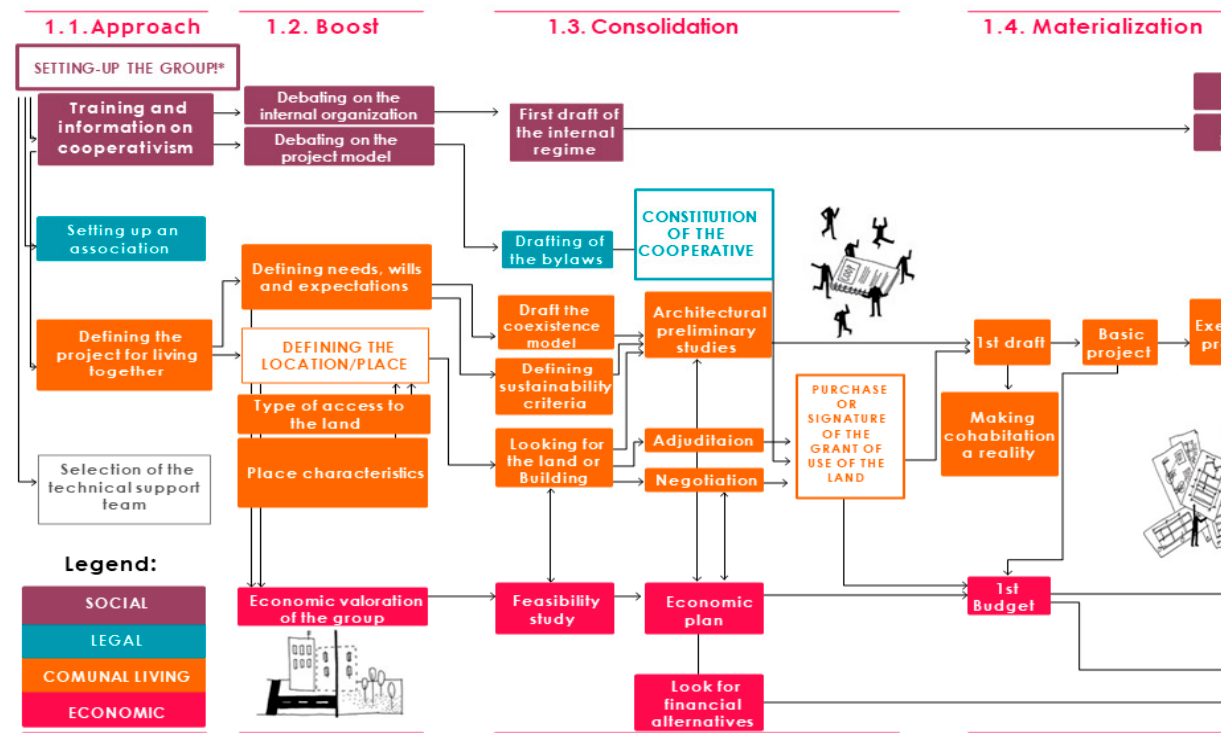
Figure 1. Stages of the cooperative housing under a GoU model.